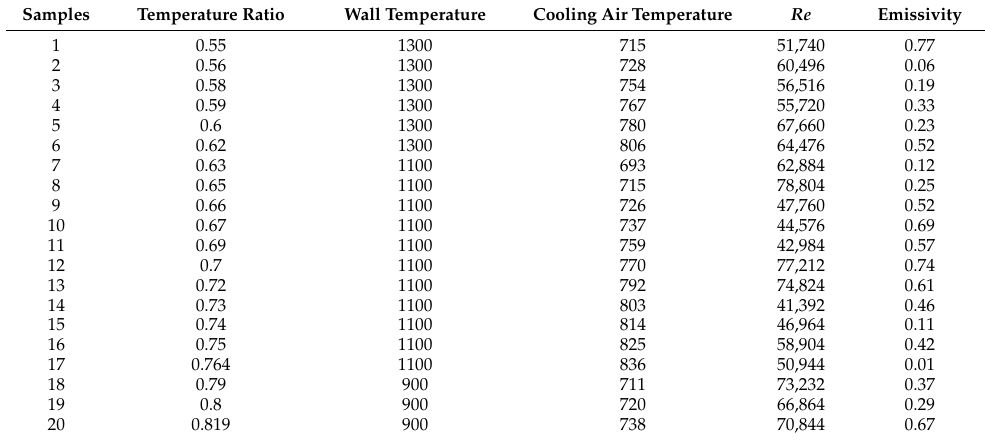
Table 6. Design of experiments.